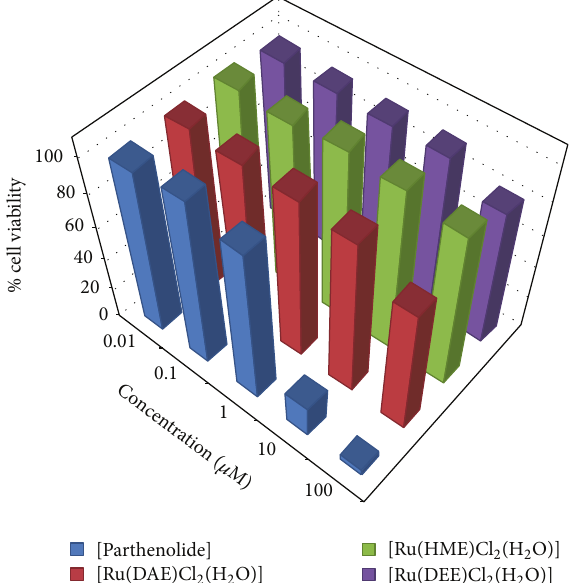
Figure 4: In vitro antiproliferative activity of Ru(III) complexes and parthenolide against human renal cancer cell (TK-10).